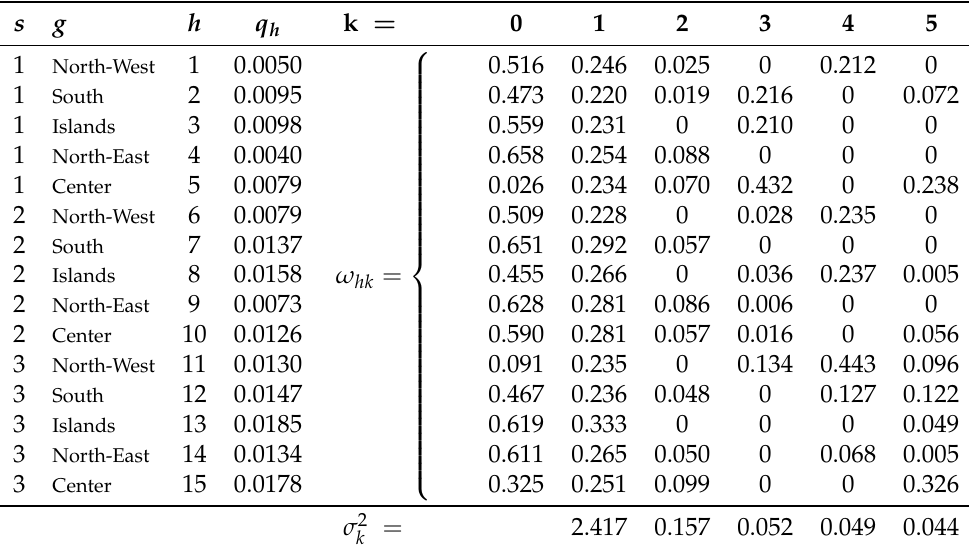
Table 2. The complete set of parameters ˆ Ω , ˆ σ 2 Γ necessary to specify the dependence structure in CreditRisk + model applied to the Italian “ Constructors ” economic